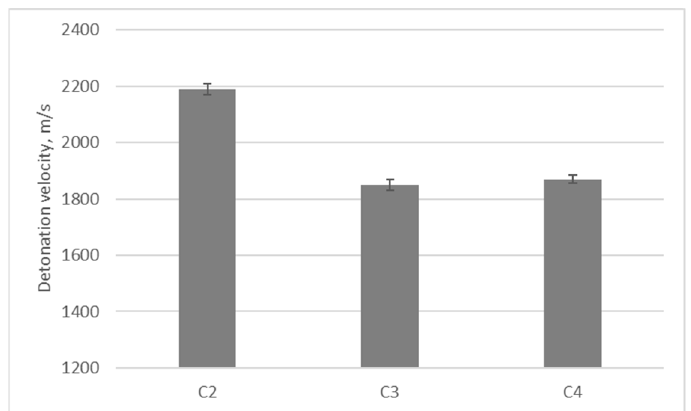
Figure 6. The dependence of the detonation velocity of AN mixtures with alcohols on the carbon chain length in a molecule.